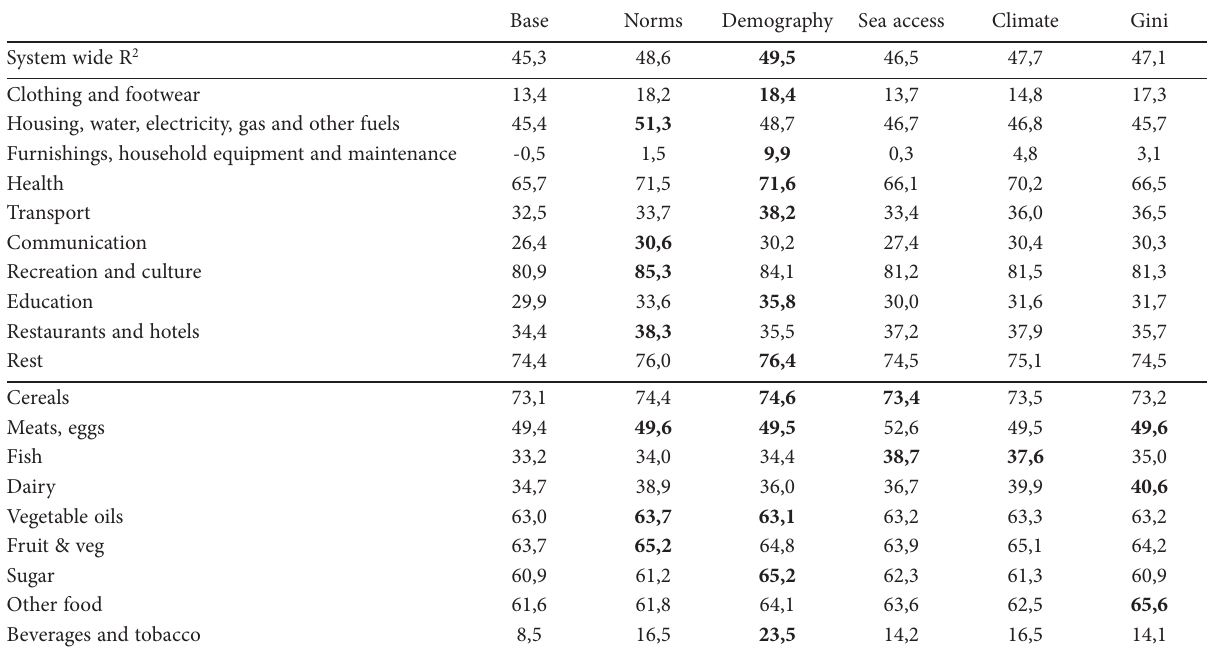
Table 6. Fit of different model variants by commodity group, single